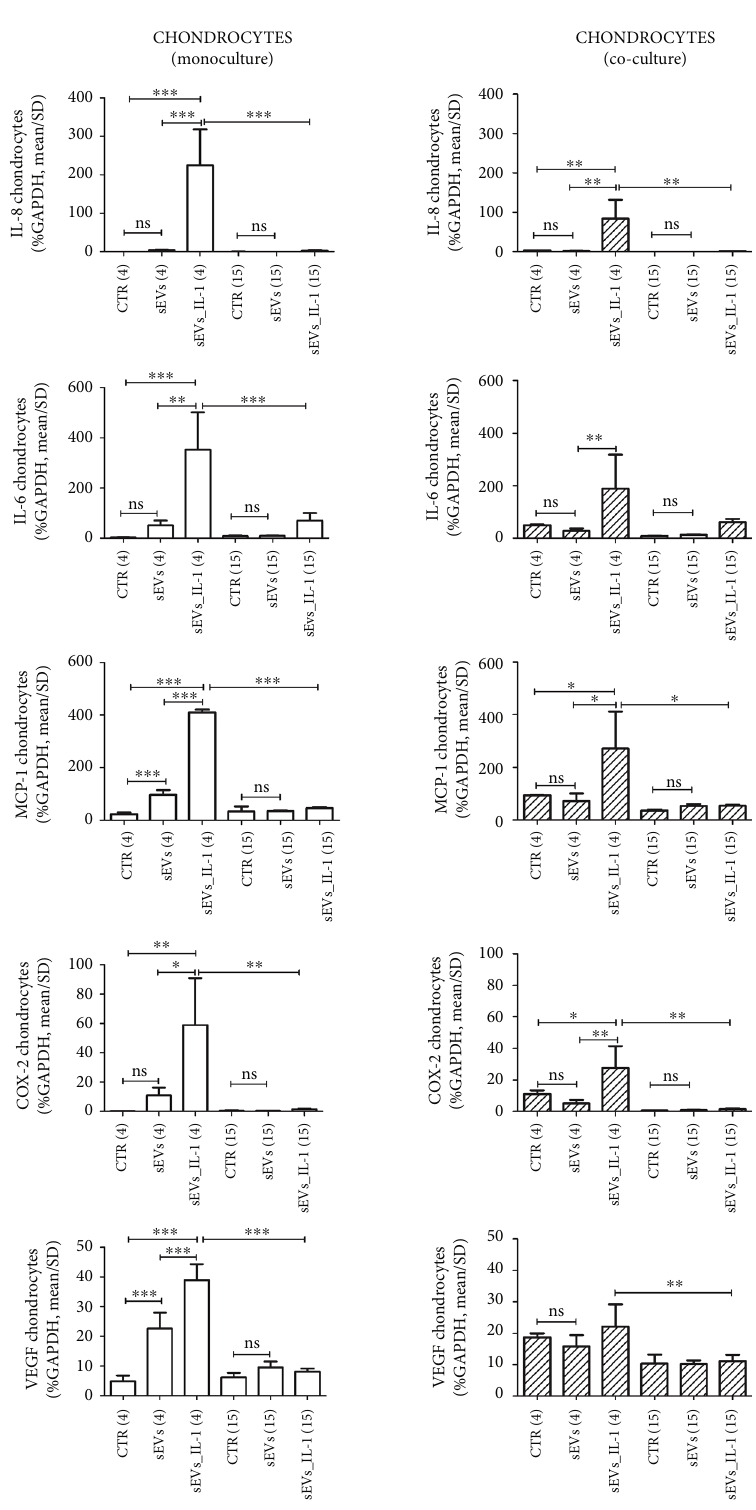
Figure 2: sEVs_IL-1 e ff ects on gene expression of major in fl ammatory genes in chondrocytes kept in control conditions. The fi gure reports the e ff ects on gene expression of major in fl ammatory molecules (IL-8, IL-6, and MCP-1) and molecules involved in angiogenesis (VEGF) and pain (COX-2) in chondrocytes grown in both monoculture (white pattern, left graphs) and co-cultured with synoviocytes (white dashed pattern, right graphs) in CTR, sEVs, or sEVs_IL-1 conditions. Data were normalized to GAPDH. Each graph reports data collected from 3 independent sEVs samples and expressed as means ± SD . The means of the groups were compared by ANOVA, followed by Tukey ’ s post hoc test, with ∗ p < 0 : 05 , ∗∗ p < 0 : 01 , and ∗∗∗ p < 0 : 001